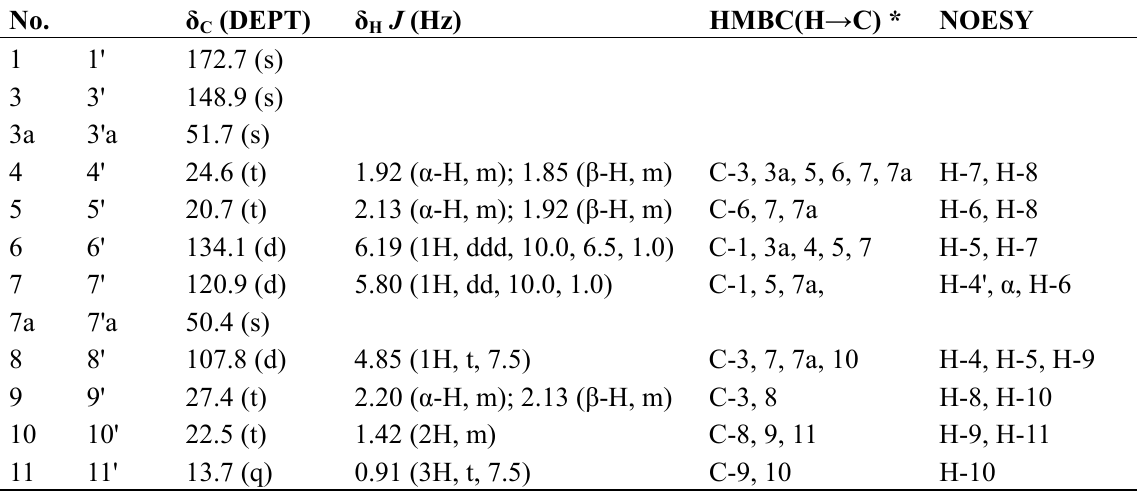
Table 1. 1 H-NMR (500 MHz) and 13 C-NMR (125 MHz) spectral data of compound 1 ) ( δ , ppm; J , (in CDCl 3